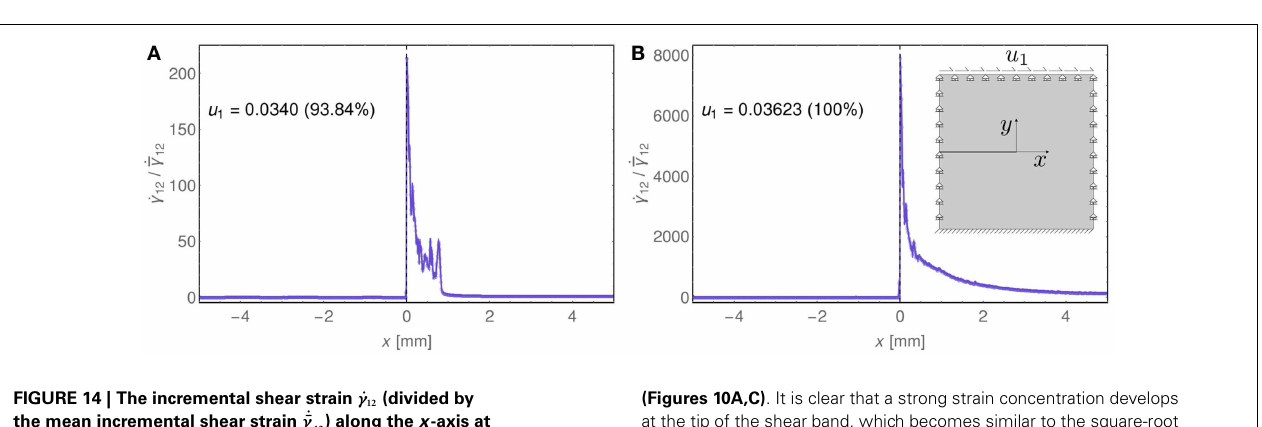
FIGURE 13 | Results for a rectangular domain ( L = 40mm, H = 10mm) of material close to shear band instability ( E p = 300MPa) and containing a pre-existing shear band (of length H /2 = 5mm and constitutive thickness 2 h = 0.01mm) . (A) Overall response curve of the block in terms of average shear stress ¯ σ 12 = T / L , where T is the total shear reaction force at the upper edge of the block, and average shear strain ¯ γ 12 = u 1 / H . (B) Magnification of